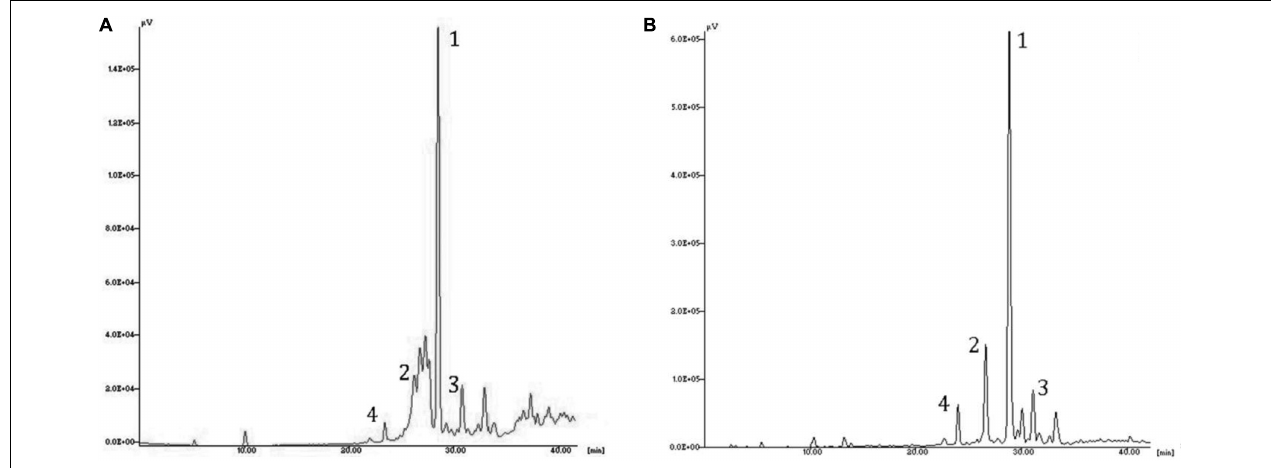
FIGURE 2 | HPLC chromatogram of the leaf extracts EF1 (A) and EF2 (B) . Assignment of the compounds to the identified peaks: (1) oleuropein, (2) luteolin-7-glucoside, (3) luteolin-4 (cid:48) -O-glucoside; (4) verbascoside.